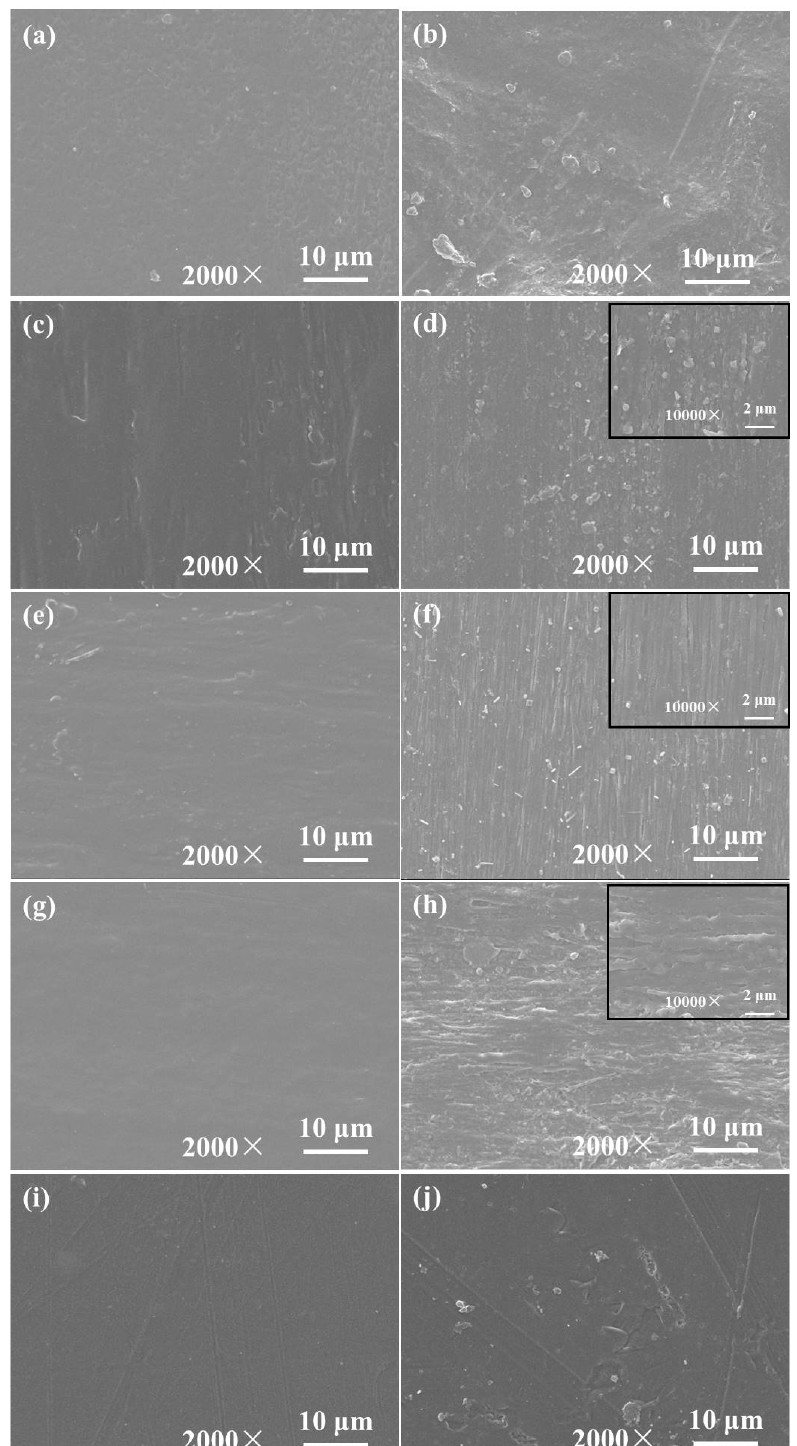
Figure 7. SEM micrographs of ( a , b ) PBAT, ( c , d ) PLA / PBAT-25, ( e , f ) PLA / PBAT-50, ( g , h ) PLA / PBAT-75 and ( i , j ) PLA before and after degradation for 24 months.